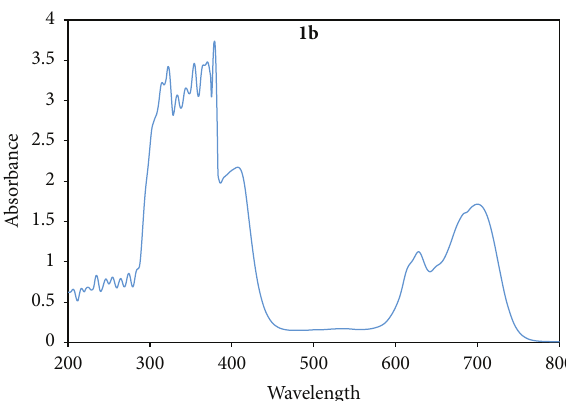
Figure 7: Electronic spectrum of Co(Ampp-Sn) 2 (H 2 O) 2 ( 1b